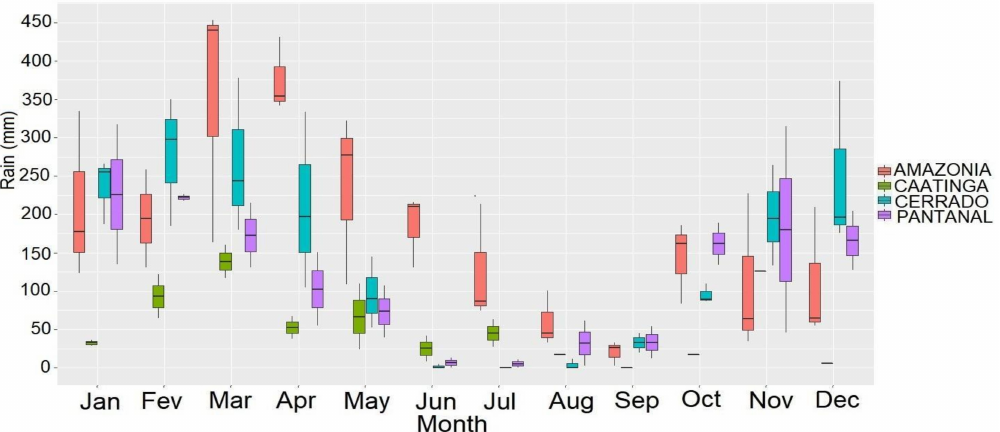
Figure 4. Monthly accumulated rainfall boxplots for each site and studied period (Amazonia: 2009–2011; Caatinga: January 2014 − July 2015; Cerrado: 2004 − 2006; Pantanal: 2015 − 2016).